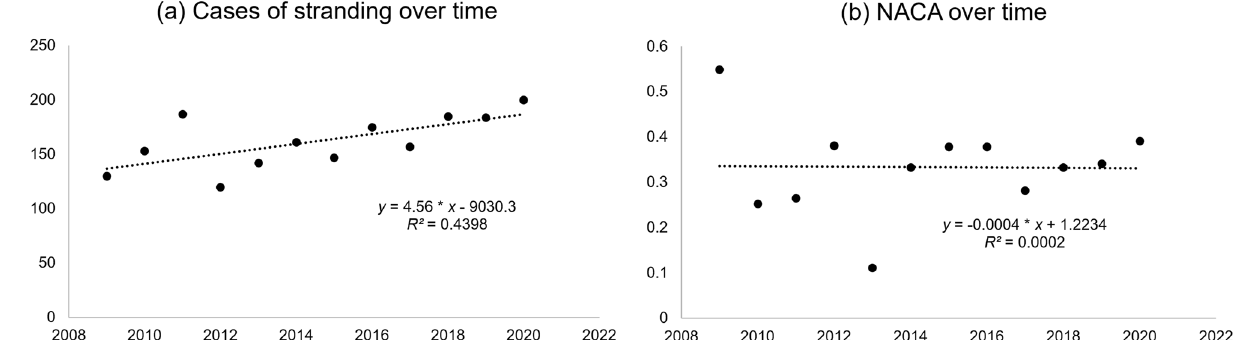
Figure 2. ( a ) Cases of being stranded over the observation period (2009–2020) based on the regression model (n = 4.5629 * time + 132.09) with a high degree of variance detection of R 2 = 0.4398. A total increase from 137 to 187 cases of approximately 36% of cases is estimated, yielding an average increase per year of 2.6%. ( b ) NACA scores of cases of being stranded over the observation period